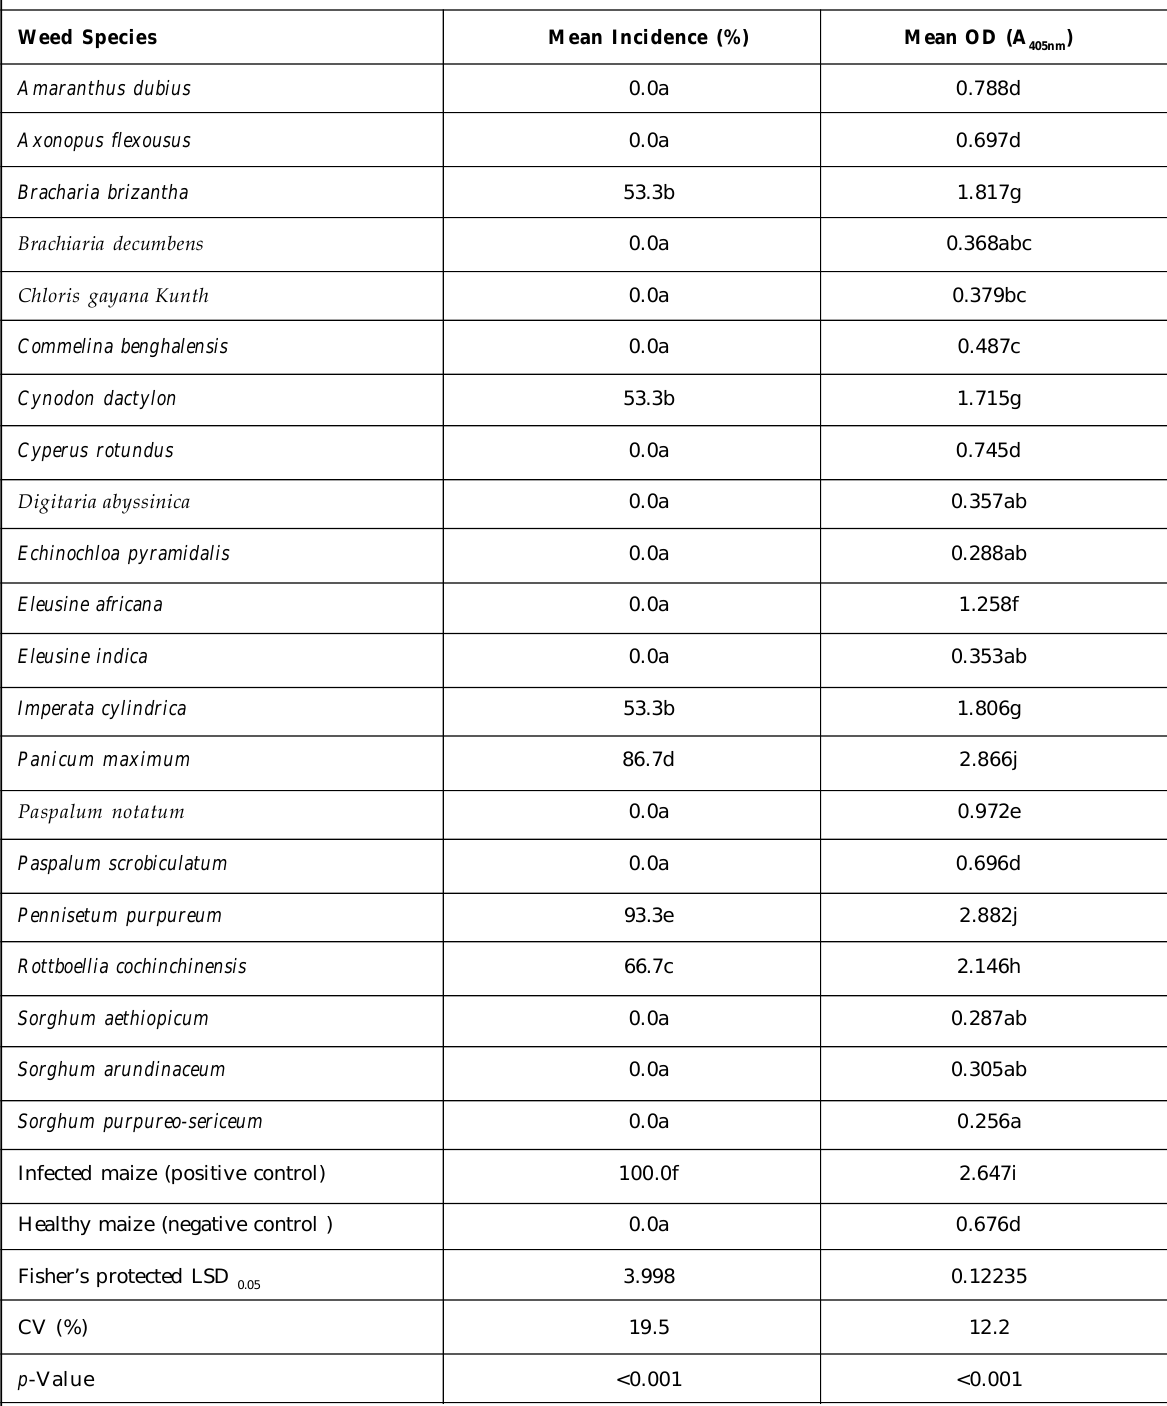
Table 4: Susceptibility of weeds species to SCMV following mechanical inoculation Weed Species Mean Incidence (%) Mean OD (A